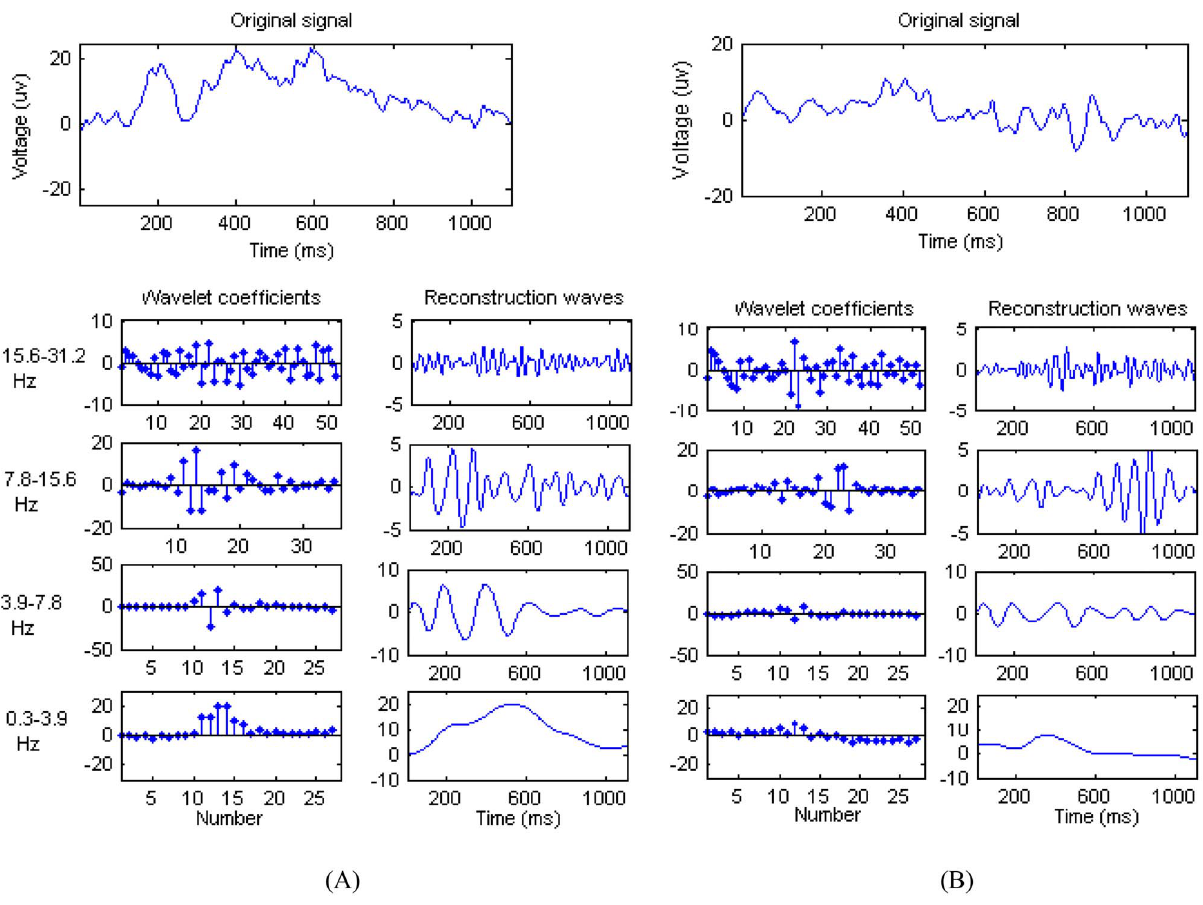
Figure 8. The wavelet coefficients in 4 bands and corresponding reconstructed waveforms. 8A: The original EEG waveforms on Pz for a guilty subject (above panel), its wavelet coefficients (left column) and corresponding reconstruction waves (right column). 8B: The original EEG waveforms on Pz for an innocent subject (above panel), its wavelet coefficients (left column) and corresponding reconstruction waves (right column).